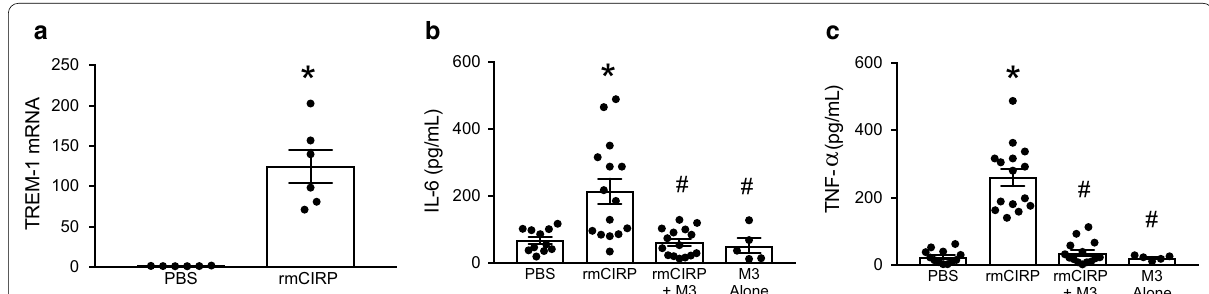
Fig. 6 The eCIRP/TREM‑1 interaction increases inflammation in cardiomyocytes. Primary murine neonatal cardiomyocytes were isolated and treated with rmCIRP for 24 h. a TREM‑1 expression was assessed by RT‑PCR (N 6/group). Cardiomyocytes were treated with rmCIRP for 24 h with = or without 20‑min pretreatment with 10 µg/mL M3. rmCIRP stimulation increased levels of b IL‑6 and c TNF‑ ⍺ in the supernatant. M3 mitigated this inflammatory response. The last column shows M3 treatment alone as a control. Data are result of 2 independent experiments and expressed as means SE and compared by Kruskal–Wallis test with Dunn method (*p < 0.05 vs. PBS control and # p < 0.05 vs. rmCIRP‑treated cells; PBS ± rmCIRP 15, rmCIRP M3 15, and M3 alone = + = =